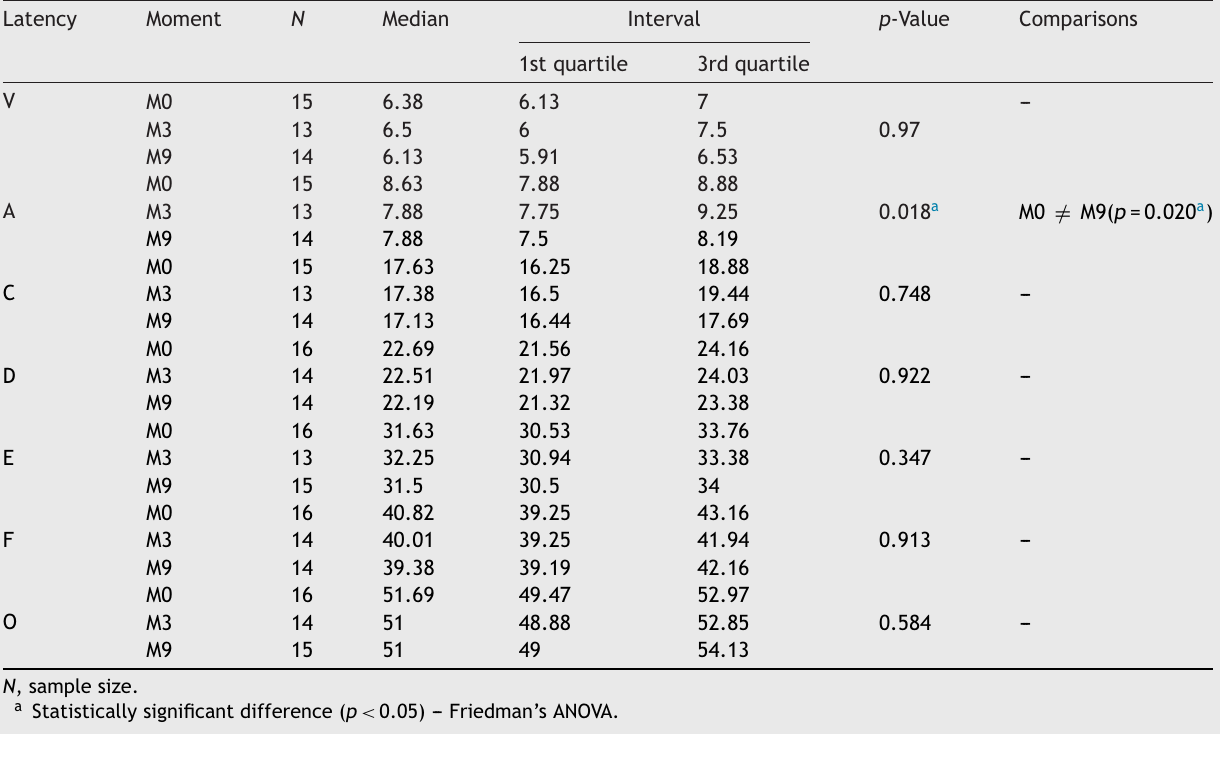
Comparison of ABR latencies with speech stimulus in the study group.